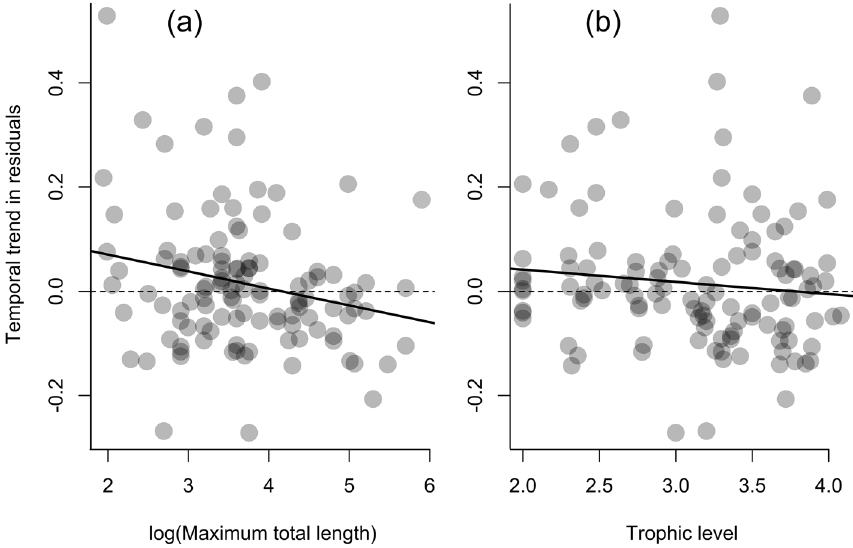
Figure 1. Temporal trend in residuals from the linear models relating species’ catch to Flood Index and water temperature against ( a ) log-transformed fish species’ maximum total length and ( b ) trophic level. The results indicated that 50% of species showed a declining trend in residuals, and this decline was significantly stronger for large-bodied fish species (p-value =